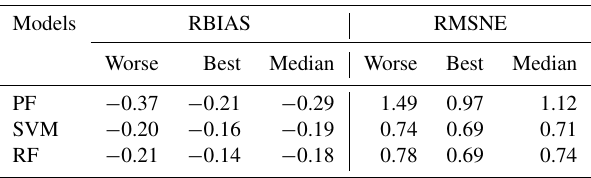
Table 5. Results of 100-year design flood estimation using 10-fold